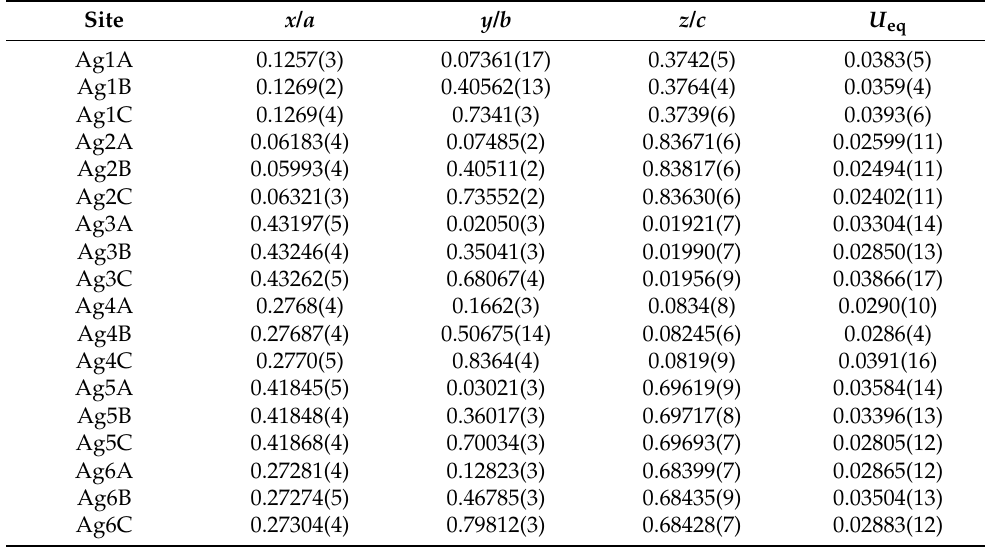
Table 2. Atom coordinates and equivalent isotropic displacement parameters (Å 2 ) for